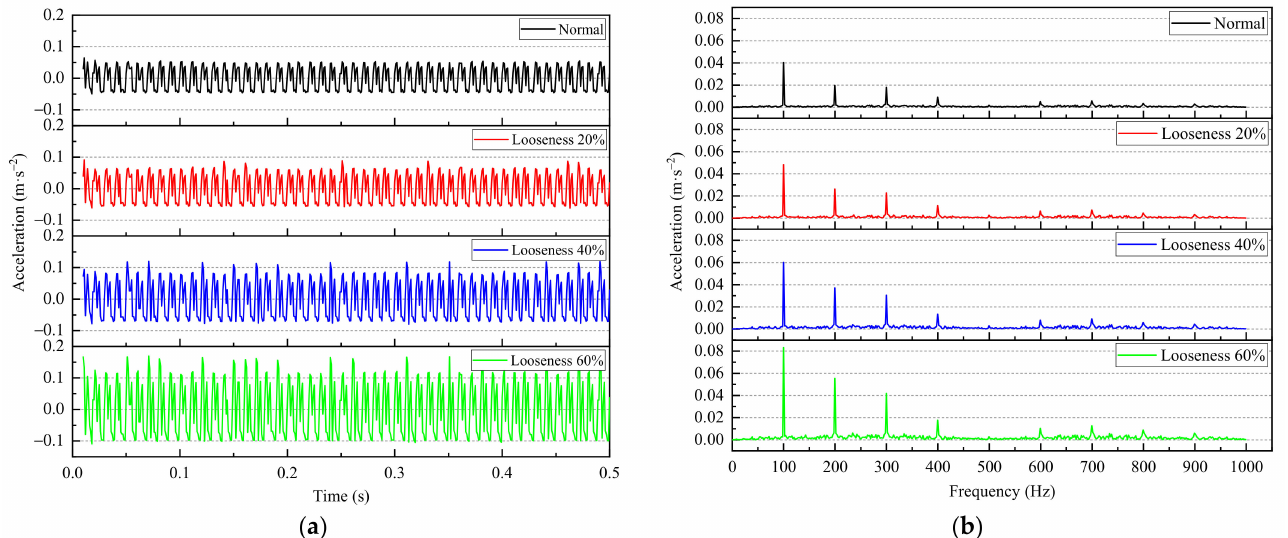
Figure 9. Acceleration signal at one winding surface point under normal and different looseness faults. ( a ) Time domain signal of acceleration under normal and loose working conditions; ( b ) frequency domain signal of acceleration under normal and loose working